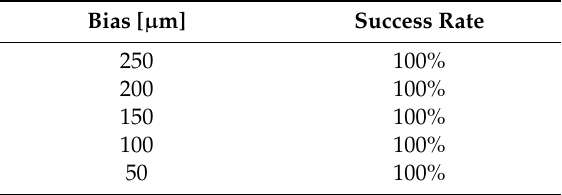
Table 2. Influence of bias on